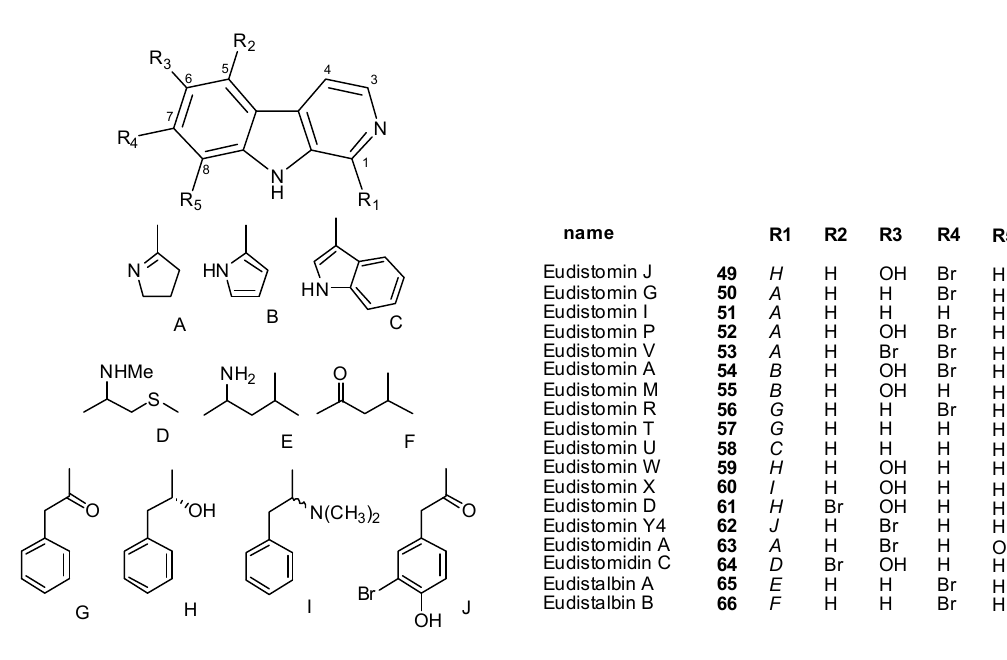
Figure 4. Simple β -carbolines.